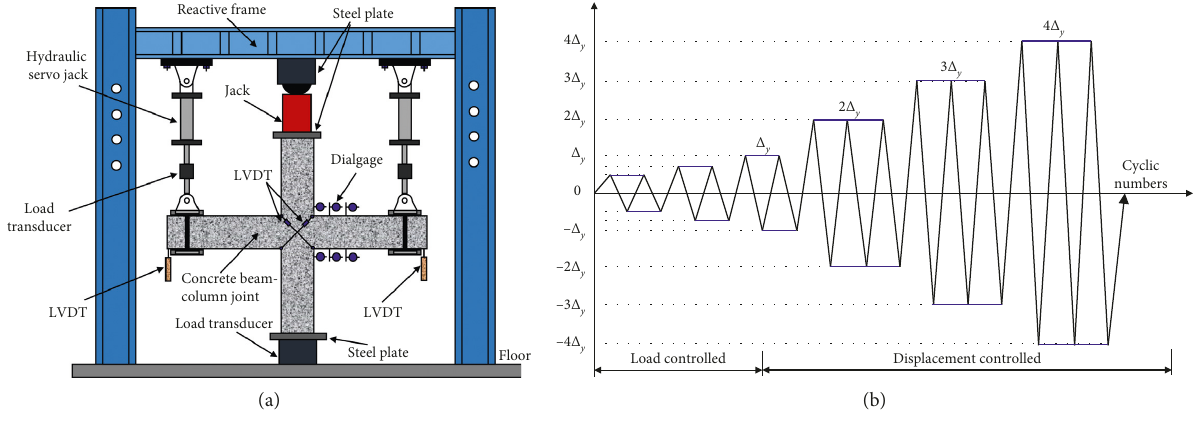
Figure 27: Schematic diagram of (a) setup; (b) loading